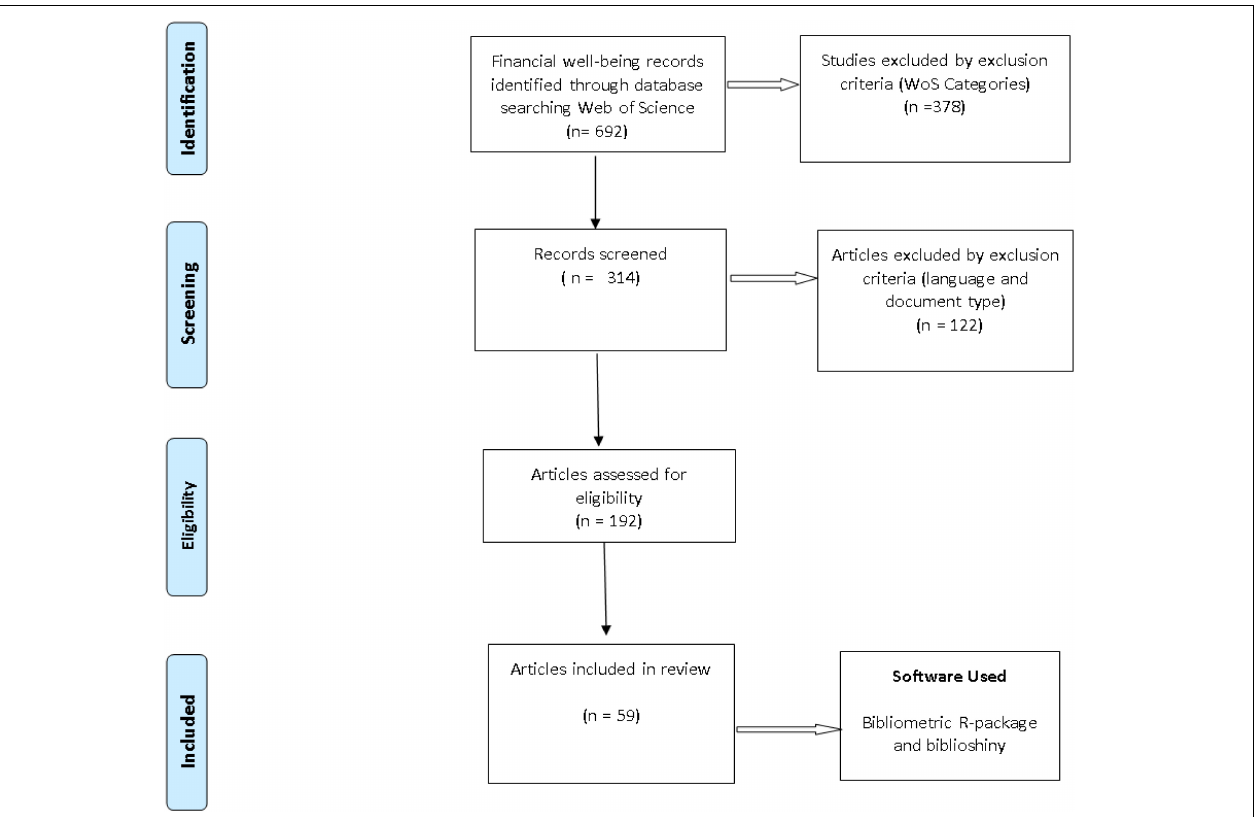
FIGURE 1 | Preferred reporting items for bibliometric review framework (summary of the selection